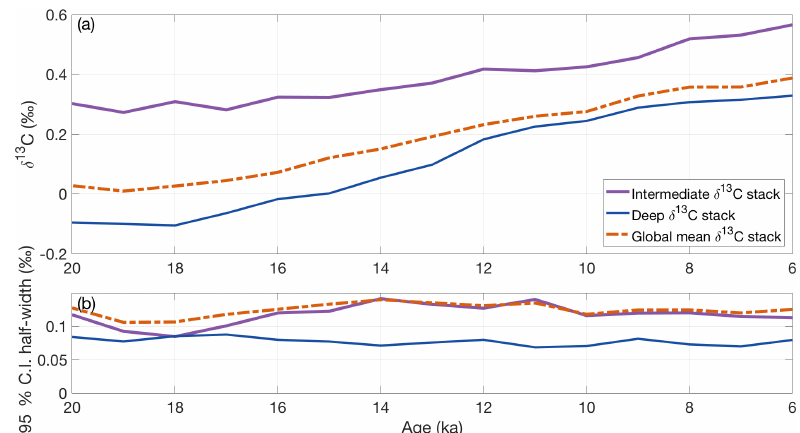
Figure 4. Volume-weighted stacks. (a) The volume-weighted global stack is calculated based on all nine regional stacks. However, the intermediate and deep stacks shown here only include Atlantic and Pacific data due to the small amount of Indian data. A comparison of these stacks with ones which include the Indian stacks is provided in Fig. S1. (b) Stack uncertainty as characterized by the 95% confidence interval half-width of each